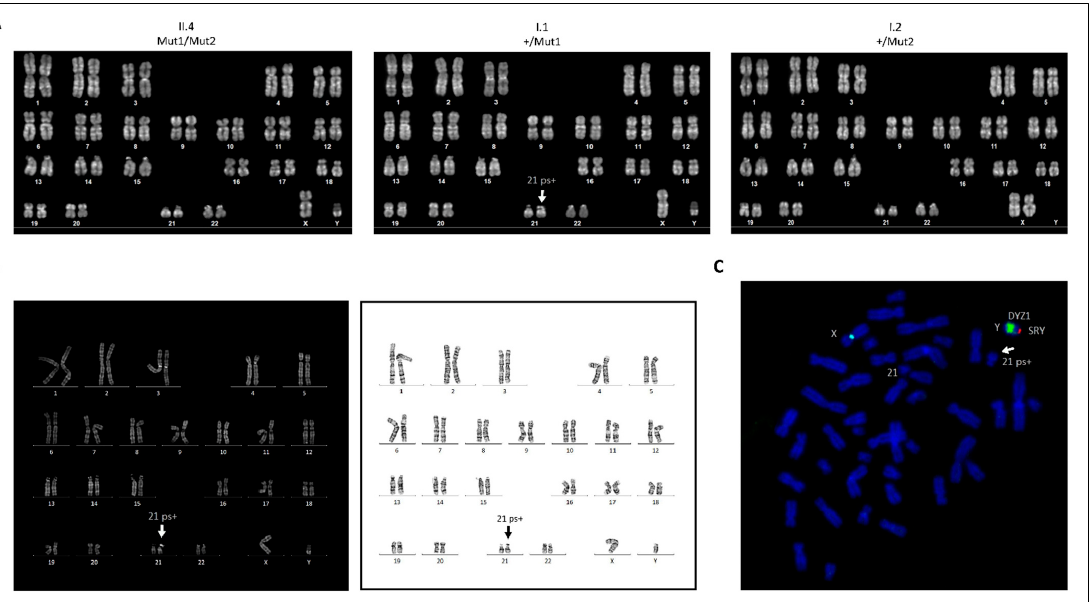
SSEA4 (green), TRA-1-60 (red) pluripotency markers. Scale bar 50 µ m. ( C ) Sanger sequencing electropherograms from the three subjects’ hiPSC cell lines at the loci of the mutations confirming the expected genotype. The genotype of a control hiPSC line is shown as reference.